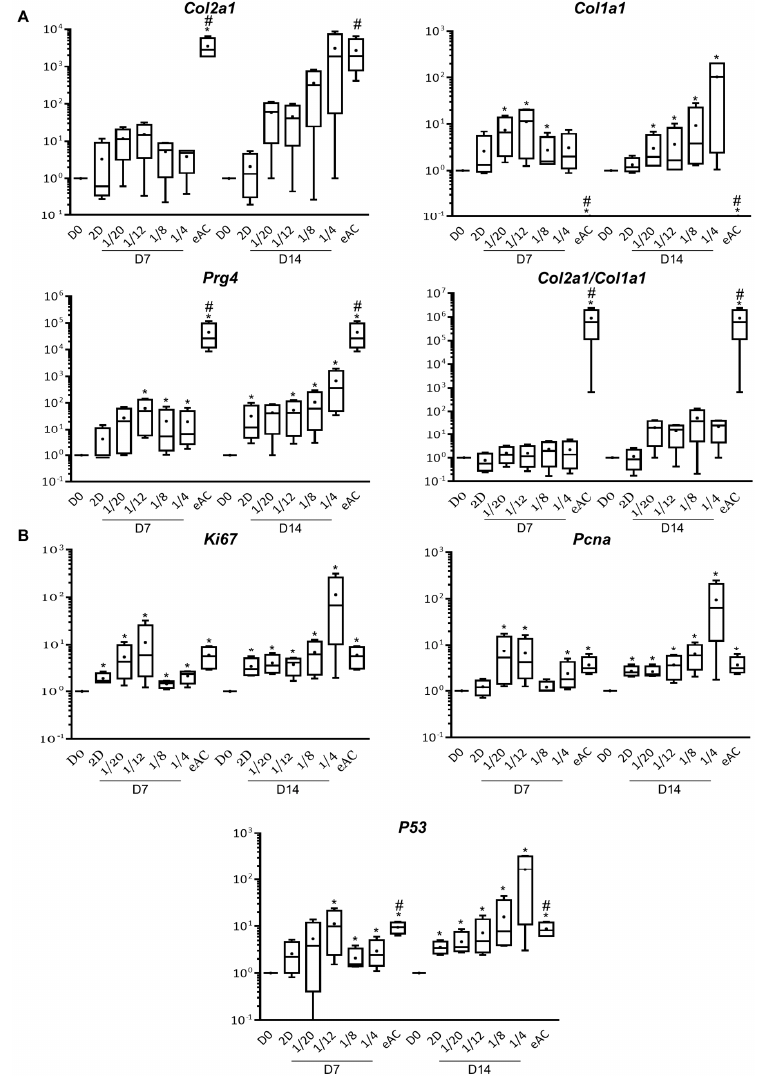
Figure 1. Analysis of eAC mRNA levels of hyaline cartilage and fibrocartilage markers, and proliferation-associated molecules when eACs were seeded in monolayer and co-cultured with MSCs at several ratios for 7 or 14 days. At P3, eACs were seeded in monolayer. Then, MSCs were co-cultured in an upper chamber for 7 or 14 days to obtain MSCs/eACs ratios from 1/20 to 1/4. Total mRNA was extracted and RT-qPCR was performed to assess the mRNA levels of hyaline cartilage and fibrocartilage markers (types II and I collagens, and Prg4 ) ( A ) and proliferation-associated molecules ( Ki67 , Pcna , and P53 ) ( B ). The D0 condition corresponds to eACs cultured in monolayer until P3. The eAC condition corresponds to eACs at P0. mRNA levels were estimated by RT-qPCR after normalization relative to the β - actin reference gene. The results ( n = 4) are represented as box plots (median, quartiles, extreme values) and the statistical significance of the values was tested using the Mann–Whitney test with the D0 condition (* p < 0.05) and the 2D condition (# p < 0.05) as references. 2D-for cells cultured in monolayer; Col1a1 -gene encoding the alpha1(I) mRNA of type I collagen; Col2a1 -gene encoding the alpha1(II) mRNA of type II collagen; D0-for untreated eACs; D7-time point corresponding to the cells cultured for 7 days; D14-time point corresponding to the cells cultured for 14 days; eACs-equine articular chondrocytes; Ki67 -gene encoding the Ki67 mRNA, MSCs-mesenchymal stem cells; P0-primary culture; P3-passage 3; P53 -gene encoding the P53 mRNA; Pcna -gene encoding proliferating cell nuclear antigen mRNA; Prg4 -gene encoding proteoglycan 4; RT-qPCR-reverse transcription-quantitative polymerase chain